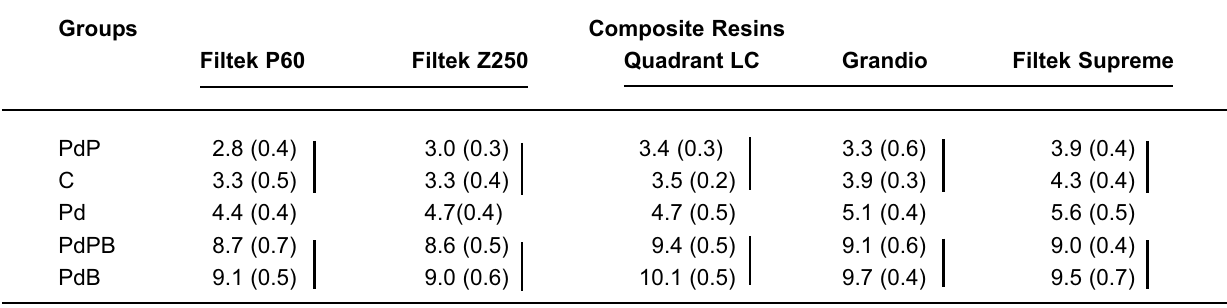
Vertical and horizontal lines connect groups that are not significantly different at p>0.05 PdP- polishing discs then diamond polishing paste; C- control; Pd- polishing discs; PdB- polishing discs then a liquid polishing system (Biscover); PdPB- a combinations of these